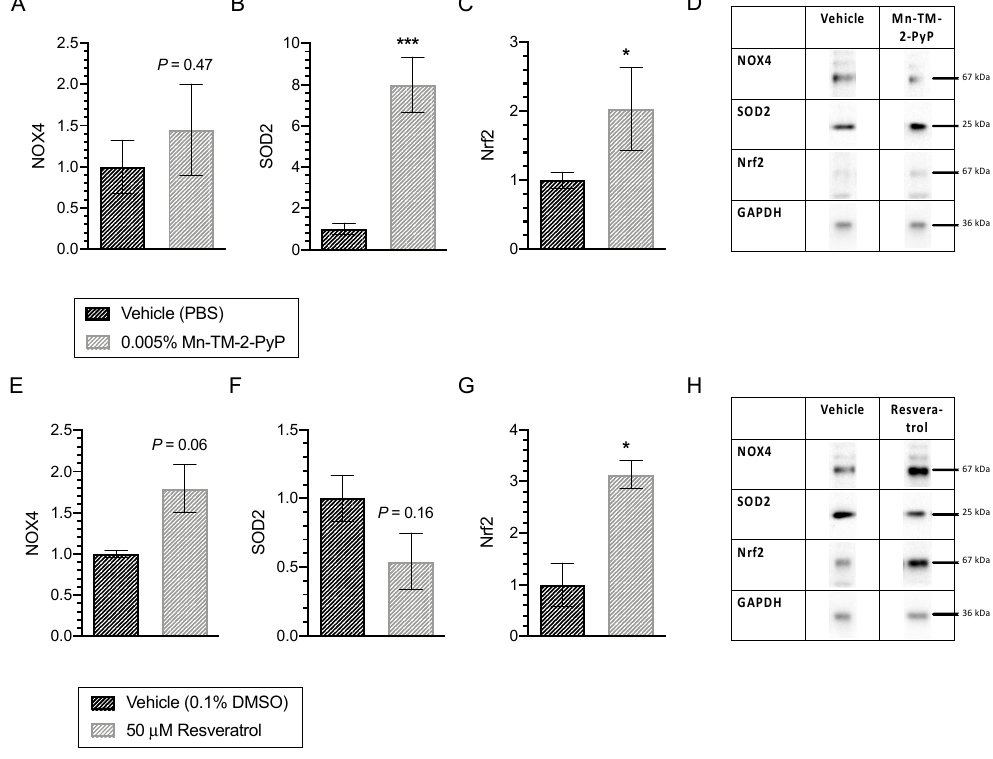
Figure 3. Di ff erential e ff ects of Mn-TM-2-PyP and resveratrol on expression levels of Nrf2, Figure 3. Differential effects of Mn-TM-2-PyP and resveratrol on expression levels of Nrf2, SOD2, and NOX4 in control optic nerve head astrocytes. ( A–C ) Mn-TM-2-PyP elicited no significant effect on